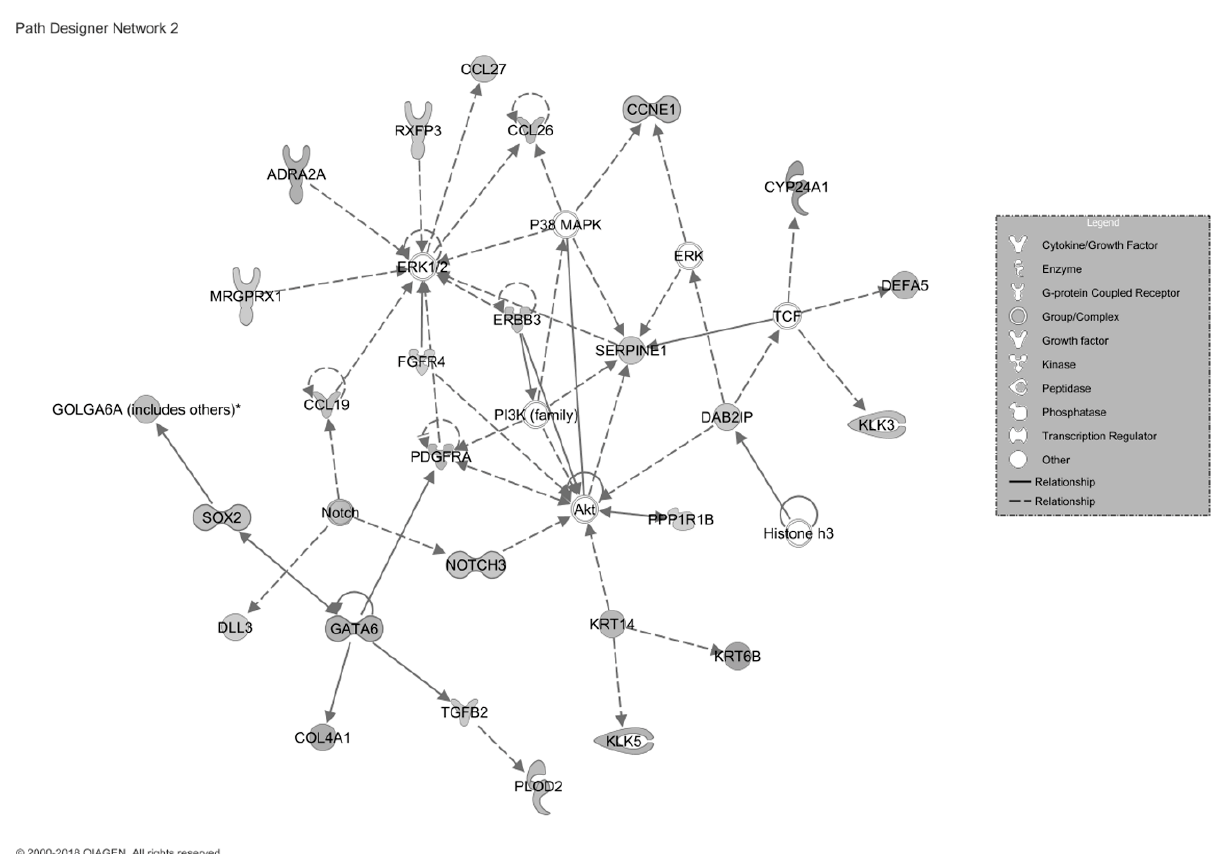
Figure 4. Representation of the gastrointestinal signaling pathway. The 27 filled icons represent increased gene expression, demonstrating activation of the pathway proposed to be associated with the manifestation of gastrointestinal ADRs.